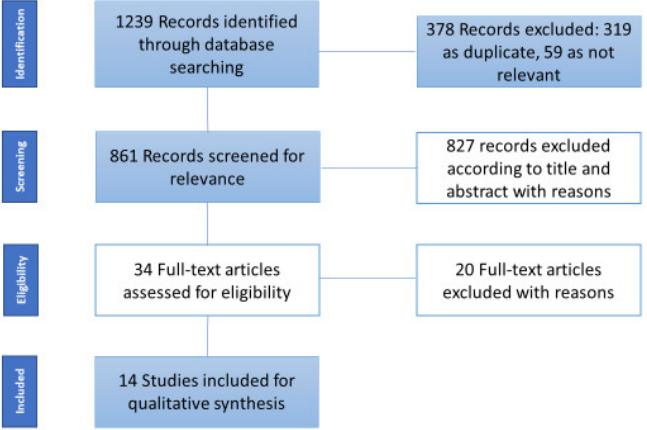
Figure 1. Flow diagram of sources selection process.